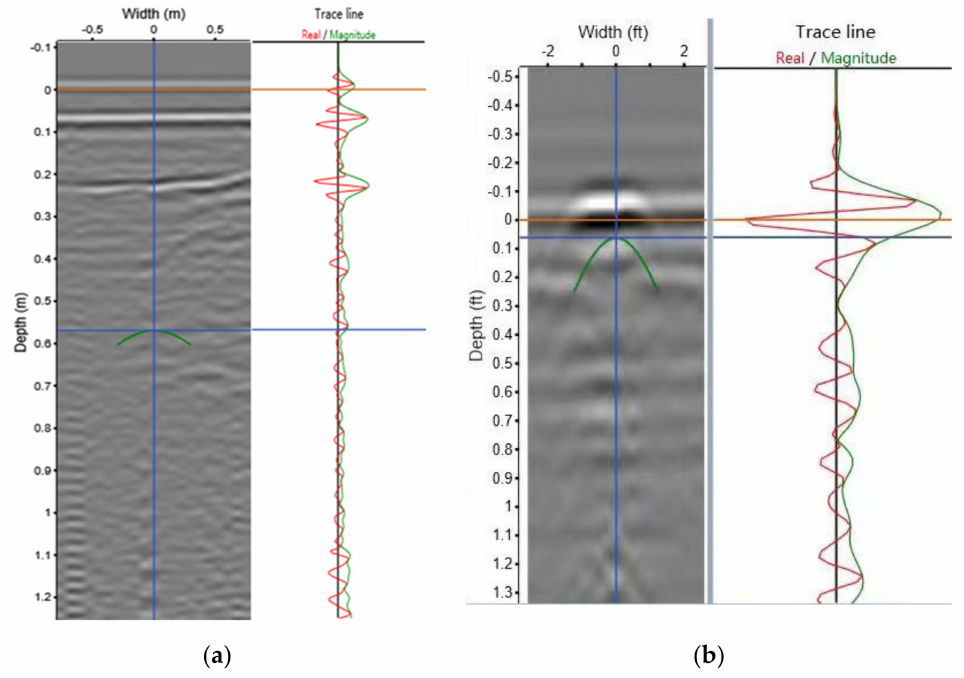
Figure 2. The amplitude of the GPR test. ( a ) Reflection on the surface; ( b ) Reflection on a metal